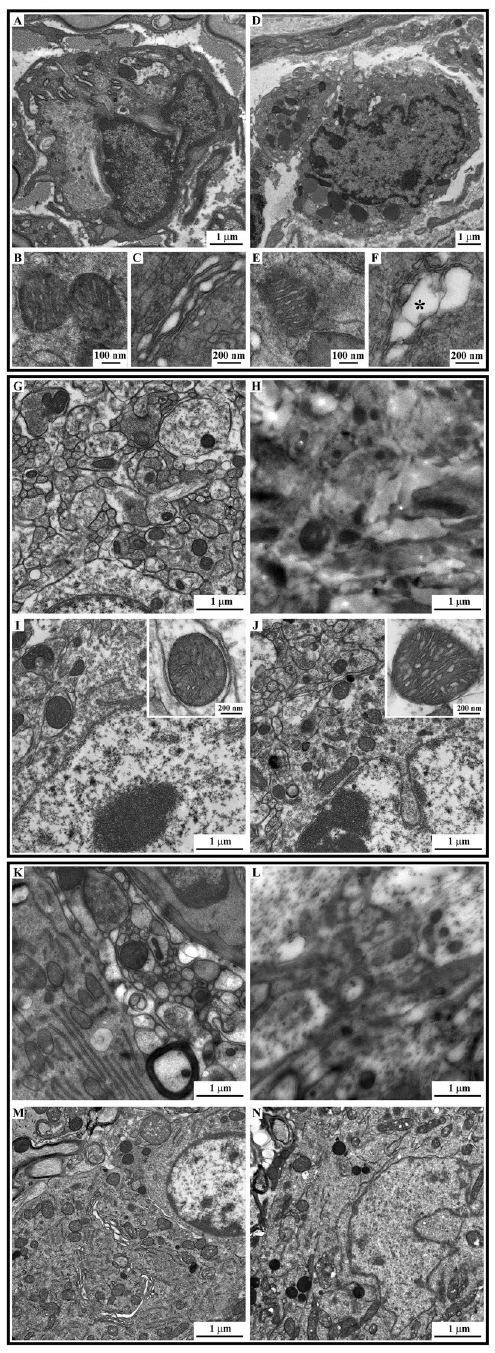
Figure 3. The protocol optimization: ultrastructural results. Upper panel: respectively, electron micrographs of a globoid cell (pathological hallmark), of a mitochondria and of a Golgi apparatus derived from a sciatic nerve treated with the ideal-size protocol ( A–C ) or with the optimized one ( D–F ). The ultrastructure is well preserved with both chemical procedures even if a mild swelling has been observed only few time in samples prepared with the optimize one ( * ). Middle panel: Electron micrographs of the ventral horns of two mice spinal cords prepared with the small-size protocol ( G , H ) and with the optimized protocol for medium-size samples ( I , J ). Representative images of the ( G and I ) outer portion and of the ( H and J ) central part of the samples − 500 µ m beyond. Ultrastructural alterations, clearely visibile in the sample prepared with the small-size protocol ( H ), are completely abolished using the optimized protocol ( I and J and insets). Lower panel: Electron micrographs of the ventral horns of two mice spinal cords prepared with the small-size protocol ( K , L ) and with the optimized protocol for medium-size samples ( M , N ). Representative images of the ( K and M ) outer portion and of the ( L and N ) central part of the samples − 500 µ m beyond. The ultrastructure of samples prepared with the optimized protocol is extremely well preserved at every depth analyzed, while this is completely loss in the sample prepared with the medium-size protocol ( L